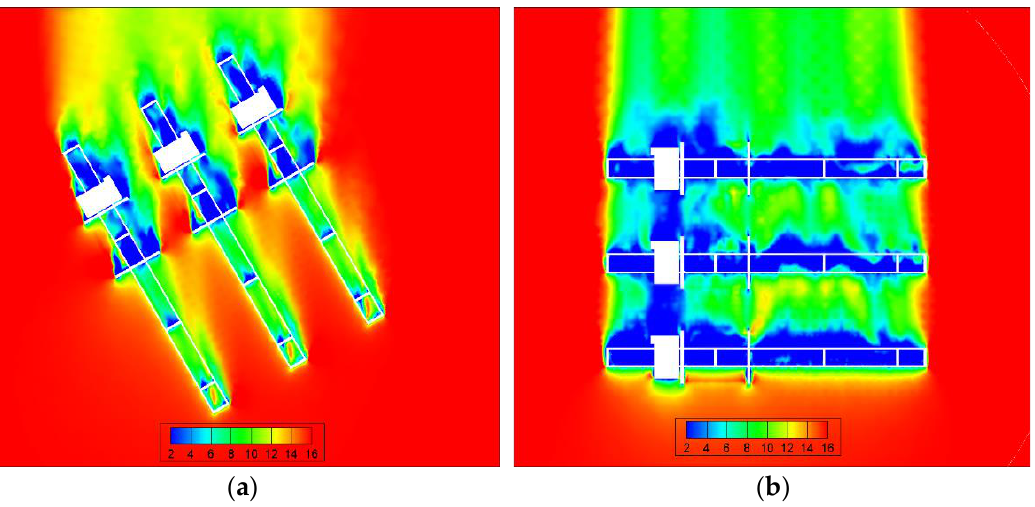
Figure 15. Contour plots of the horizontal wind velocity at the height of the jib of boom-down crane (h = 57m): ( a ) α = 30°; and ( b ) α = 90°.